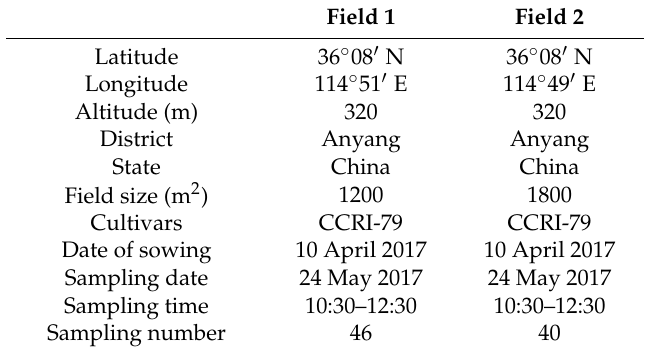
Table 1. Details of the field locations selected and sampling adopted for the study.